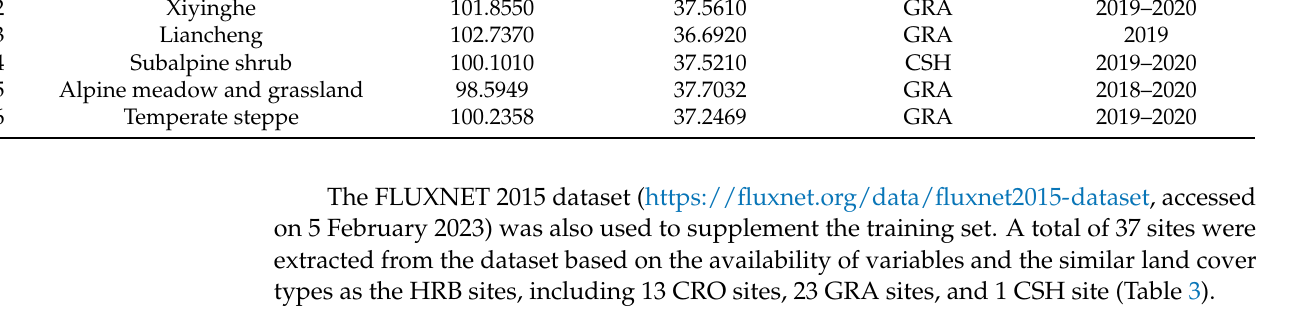
Table 3. Information of the sites in FLUXNET 2015